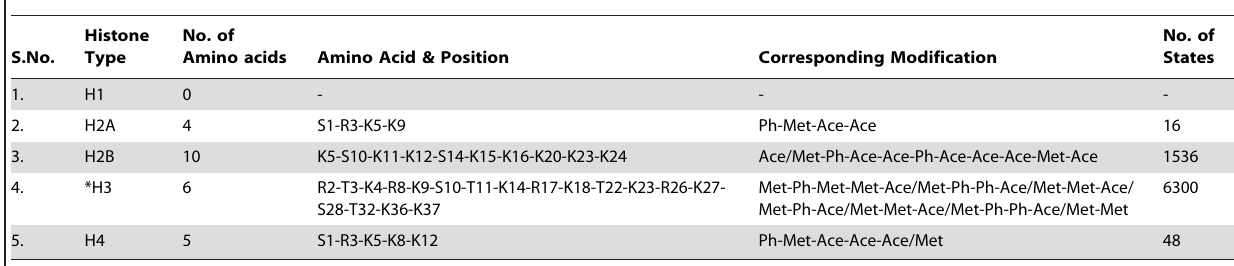
Table 1. Amino acid positions and